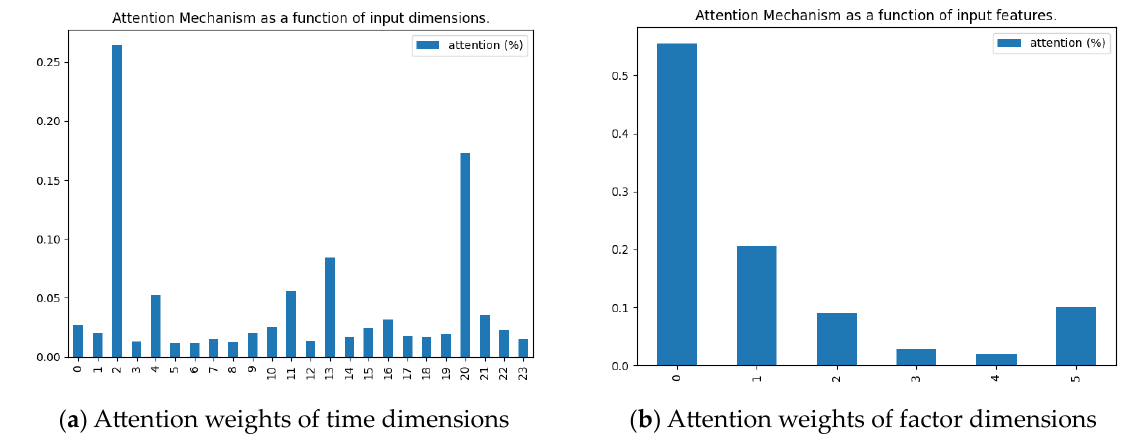
Figure 6. Time dimension and factor dimension effects on weights in the Chinese dataset. Table 6. Comparison of prediction results in terms of changes in MAPE (%) for different input data in the Chinese